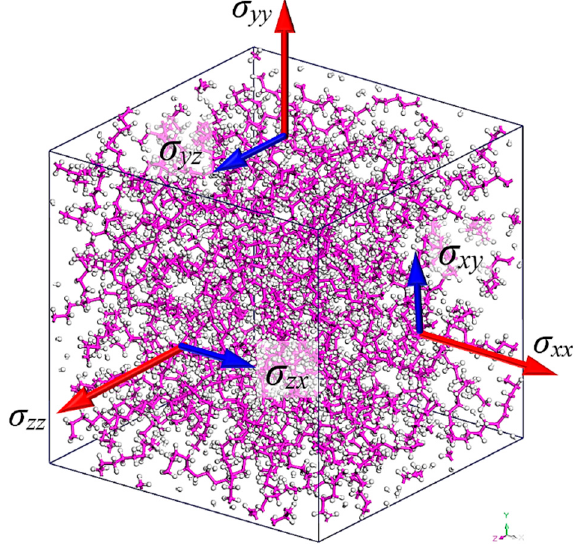
Figure 2. The equilibrated unit cell of the pure PE at T = 300